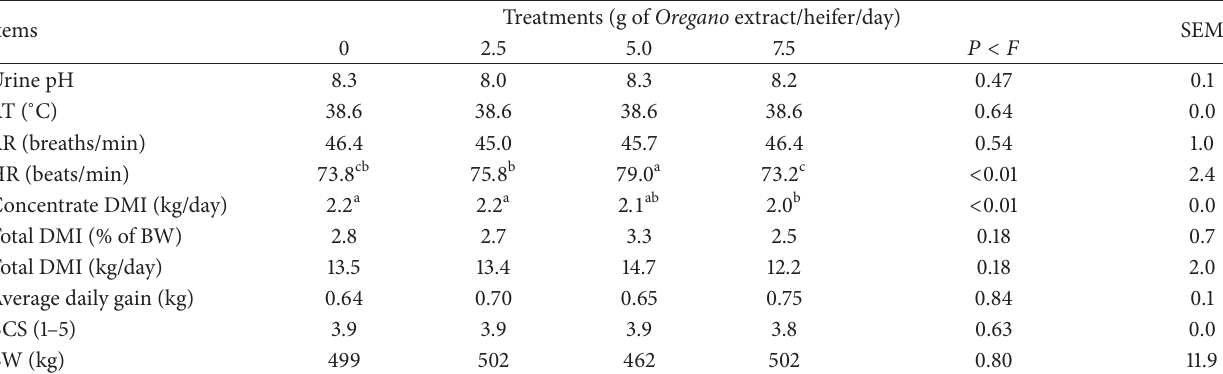
Table 3: Mean physiological measurements, performance, and dry matter intake of heifers receiving different doses of oregano extract with corresponding significance levels.